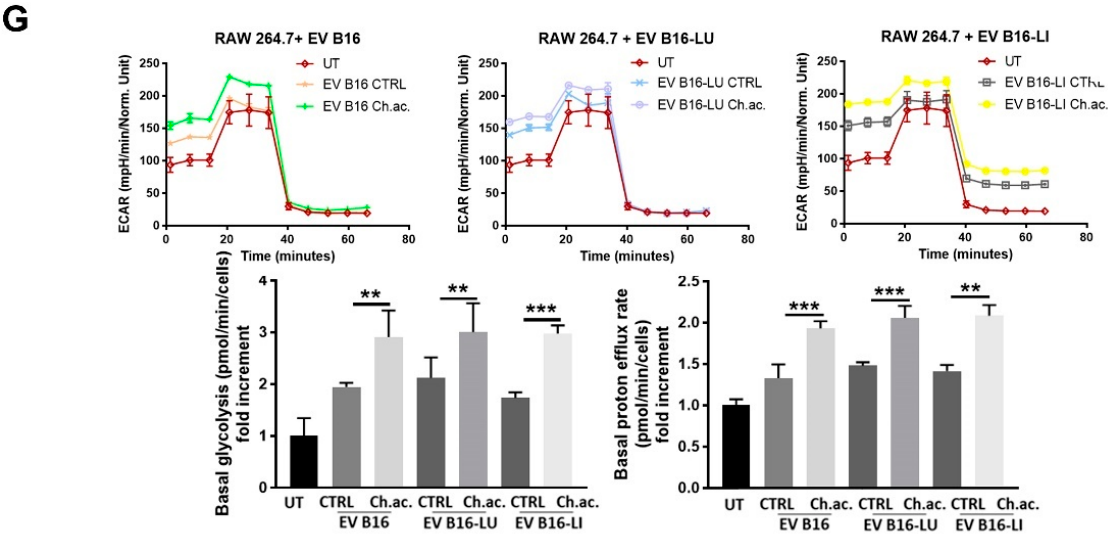
Figure 2. Inflammatory response of RAW 264.7 macrophages following the uptake of melanoma- derived acid-EV. ( A ) Immunofluorescence analysis of NF- ĸ B nuclear localization in RAW 264.7 mac- rophages treated with melanoma-derived EV (Scale bar = 10 μ m). ( B ) Western blot analysis of COX- 2 in RAW 264.7 macrophages treated with melanoma-derived EV ( p < 0.05). ( C ) Real-time qPCR of IL-1 β , IL-6, and TNF- α in RAW 264.7 macrophages treated with melanoma-derived EV (all condi- tions were found significantly different from the untreated (UT). ( D ) ELISA of IL-1 β , IL-6, and TNF- α released by RAW 264.7 macrophages treated with melanoma-derived EV. ( E ) NO production by